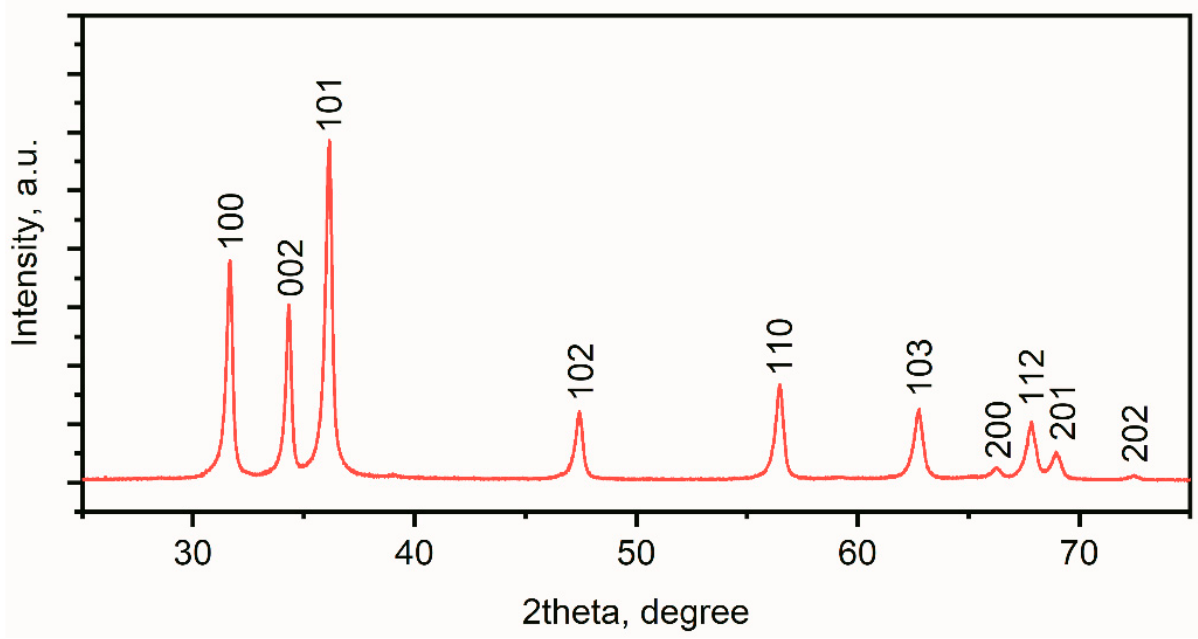
Figure 2. X-ray diffraction pattern recorded for ZnO nanoparticles. The hydrodynamic particle diameter distribution for aqueous solutions of ZnO NPs showed a stable colloidal solution with means of 360 nm (300 mg/L) and 290 nm (2000 mg/L) (Figure 3). Larger hydrodynamic diameters of the particles in colloidal solu- tion as compared to the crystalline size suggested the aggregate formation of the ZnO NPs. Such aggregates showed moderate stability observed by the ζ -potential measurements of − 21 ± 1.3 mV for (for the 300 mg/L concentration) and 6.5 ± 1.2 mV (for the 2000 mg/L concentration).